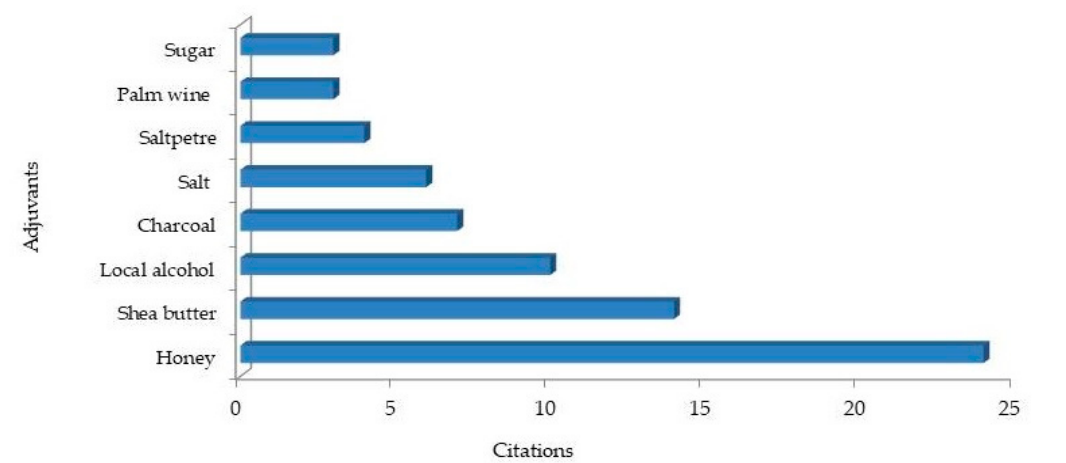
Figure 6. Non-plant ingredients added to medicinal plants used by local healers and other medicinal plant users.